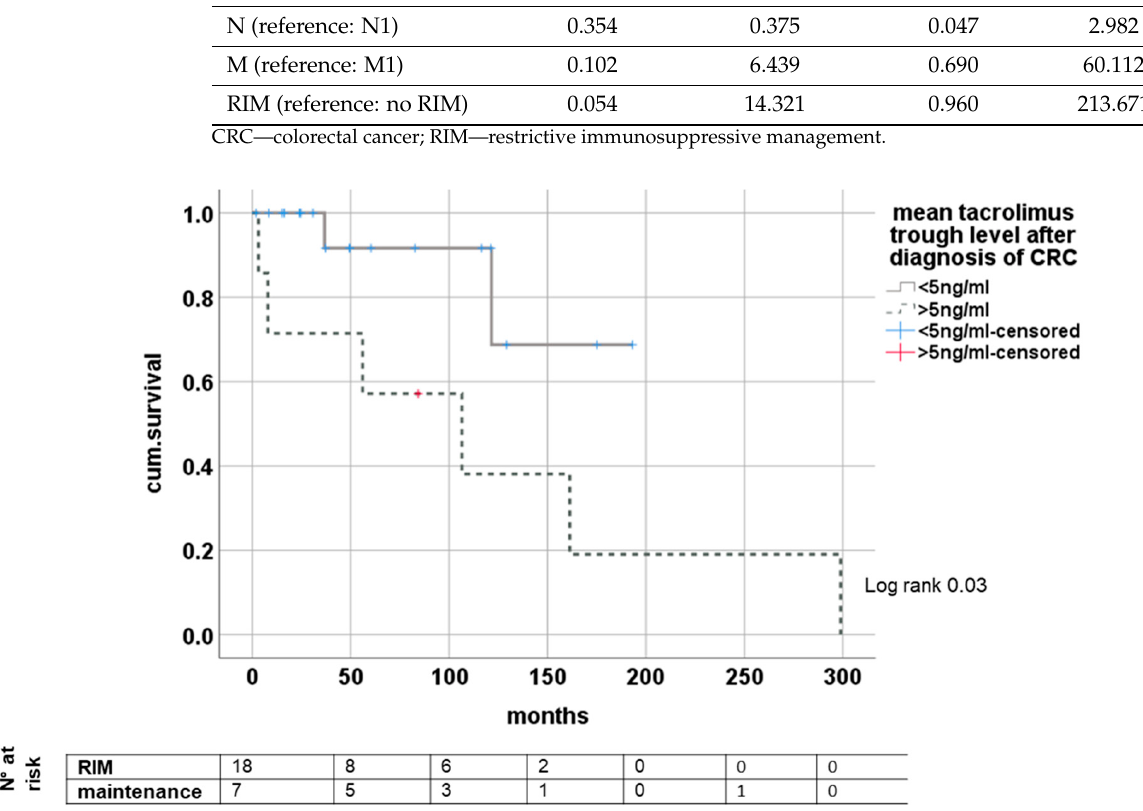
Table 2. Multivariate Regression analysis on impact of survival after diagnosis of CRC after LT.